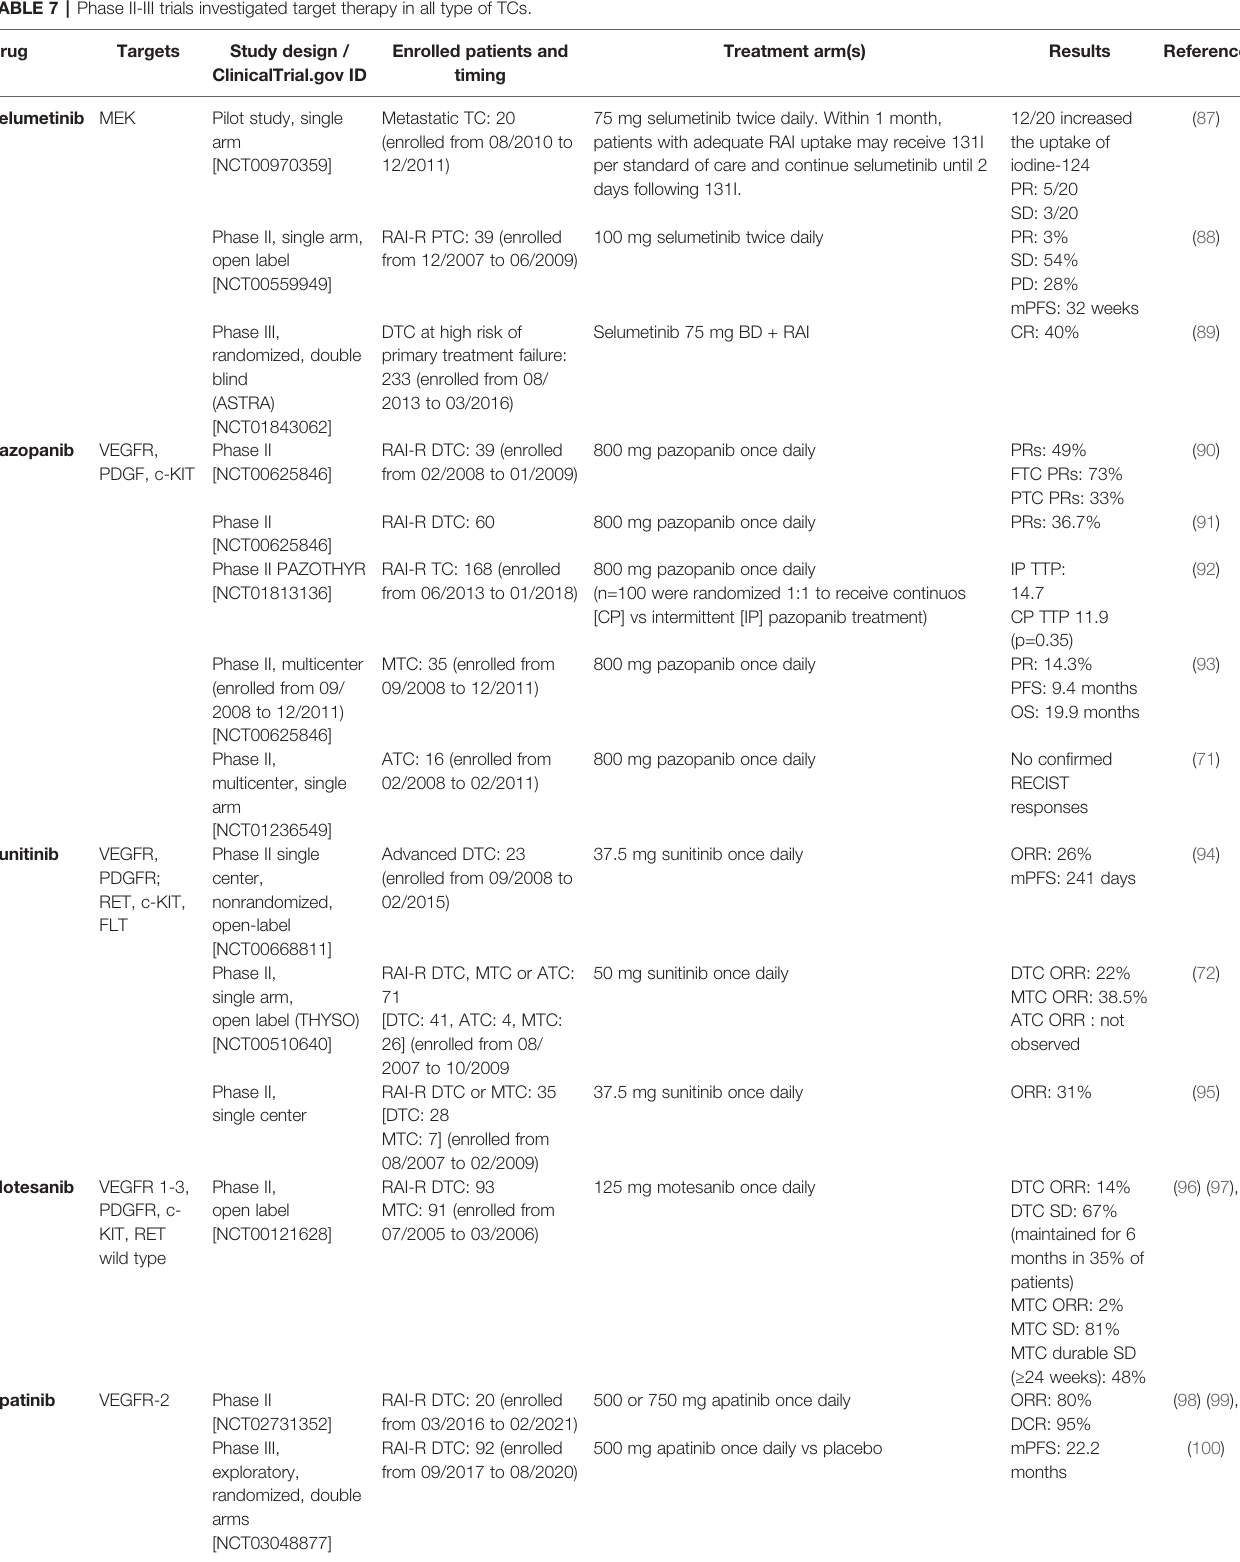
TABLE 7 | Phase II-III trials investigated target therapy in all type of TCs.